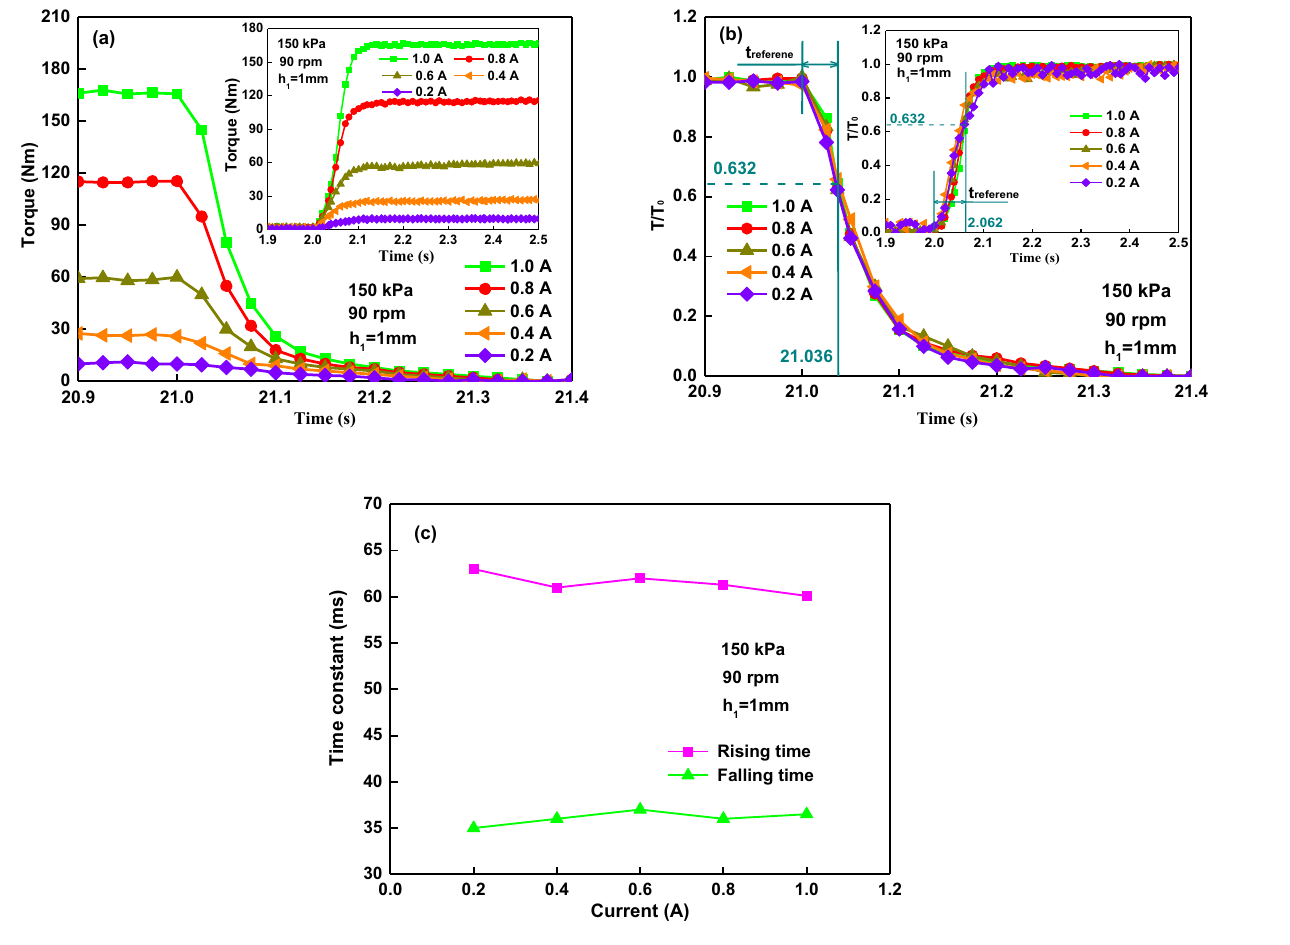
Figure 5. Torque response affected by current: ( a ) torque versus time; ( b ) normalized torque versus time; ( c ) rising and falling time constant versus the current.